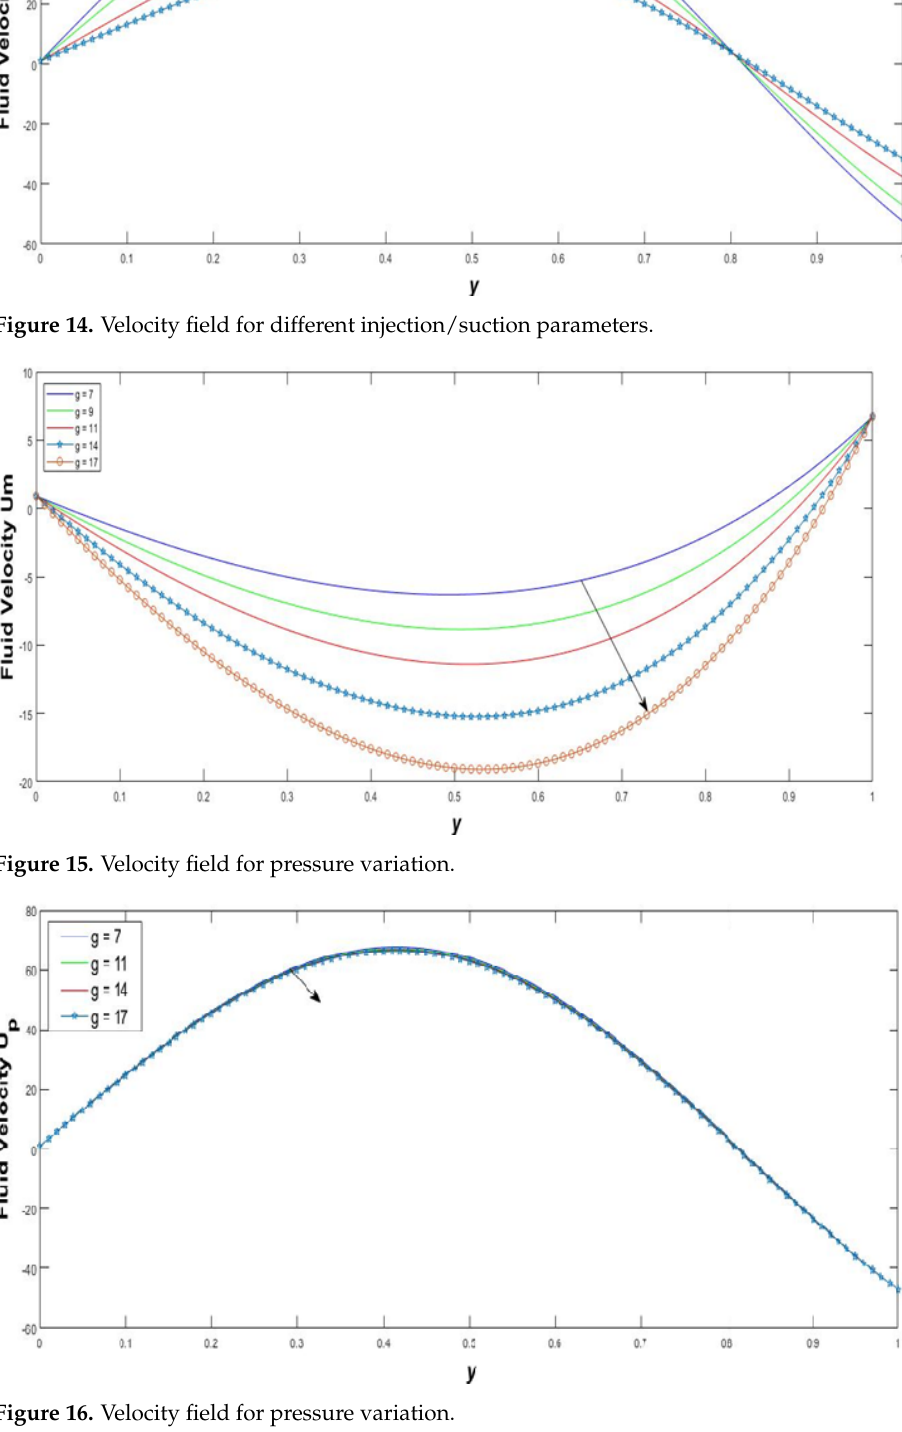
Figure 16. Velocity field for pressure